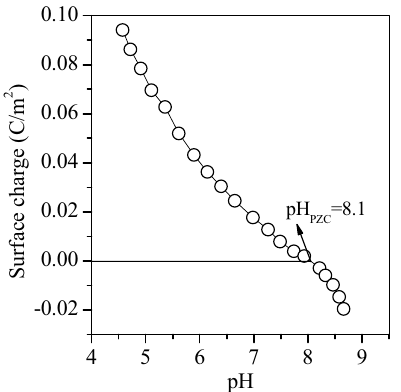
Figure 7. pH PZC of magnetic adsorbent Na500.